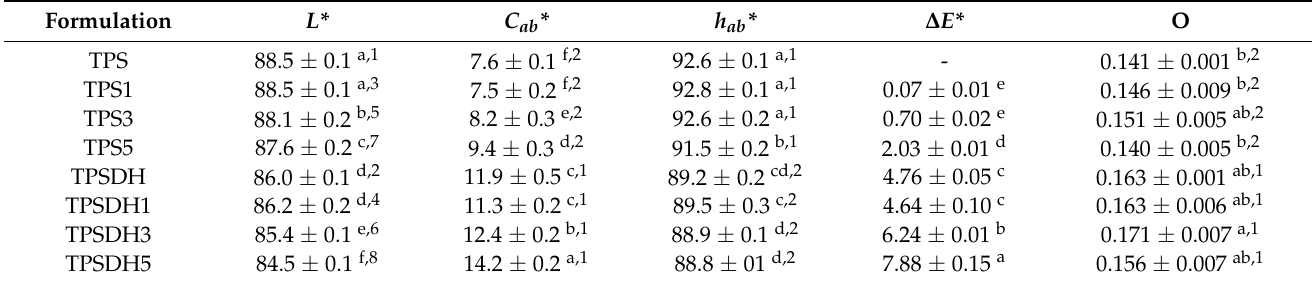
Different subscript letters indicate significant differences between samples of the same group (TPS or TPSDH films). Different numbers indicated significant differences between TPS and TPSDH samples with the same ratio of CMF (Tukey test, p <